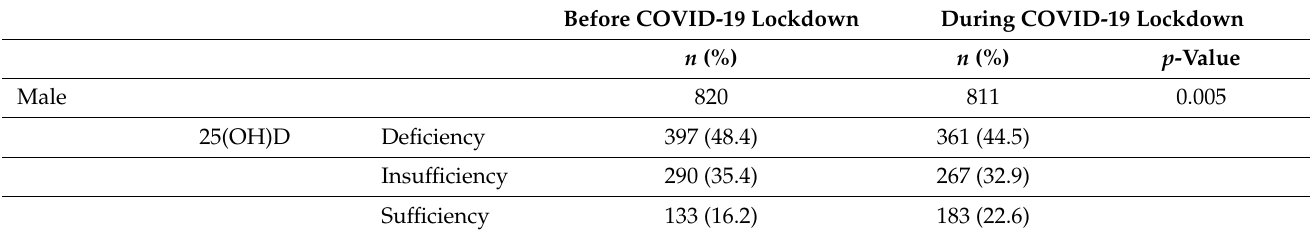
Table 3. Seasonal serum 25(OH)D levels before and during the COVID-19 lockdown period . Table 4. The rates of 25(OH)D deficiency, insufficiency, and sufficiency before and during COVID-19 lockdown